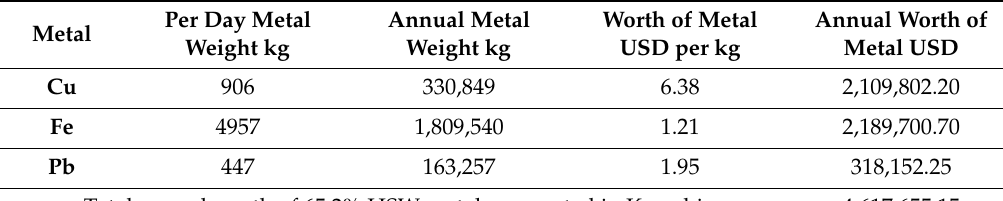
Table 4. Annual worth estimation of Cu, Fe and